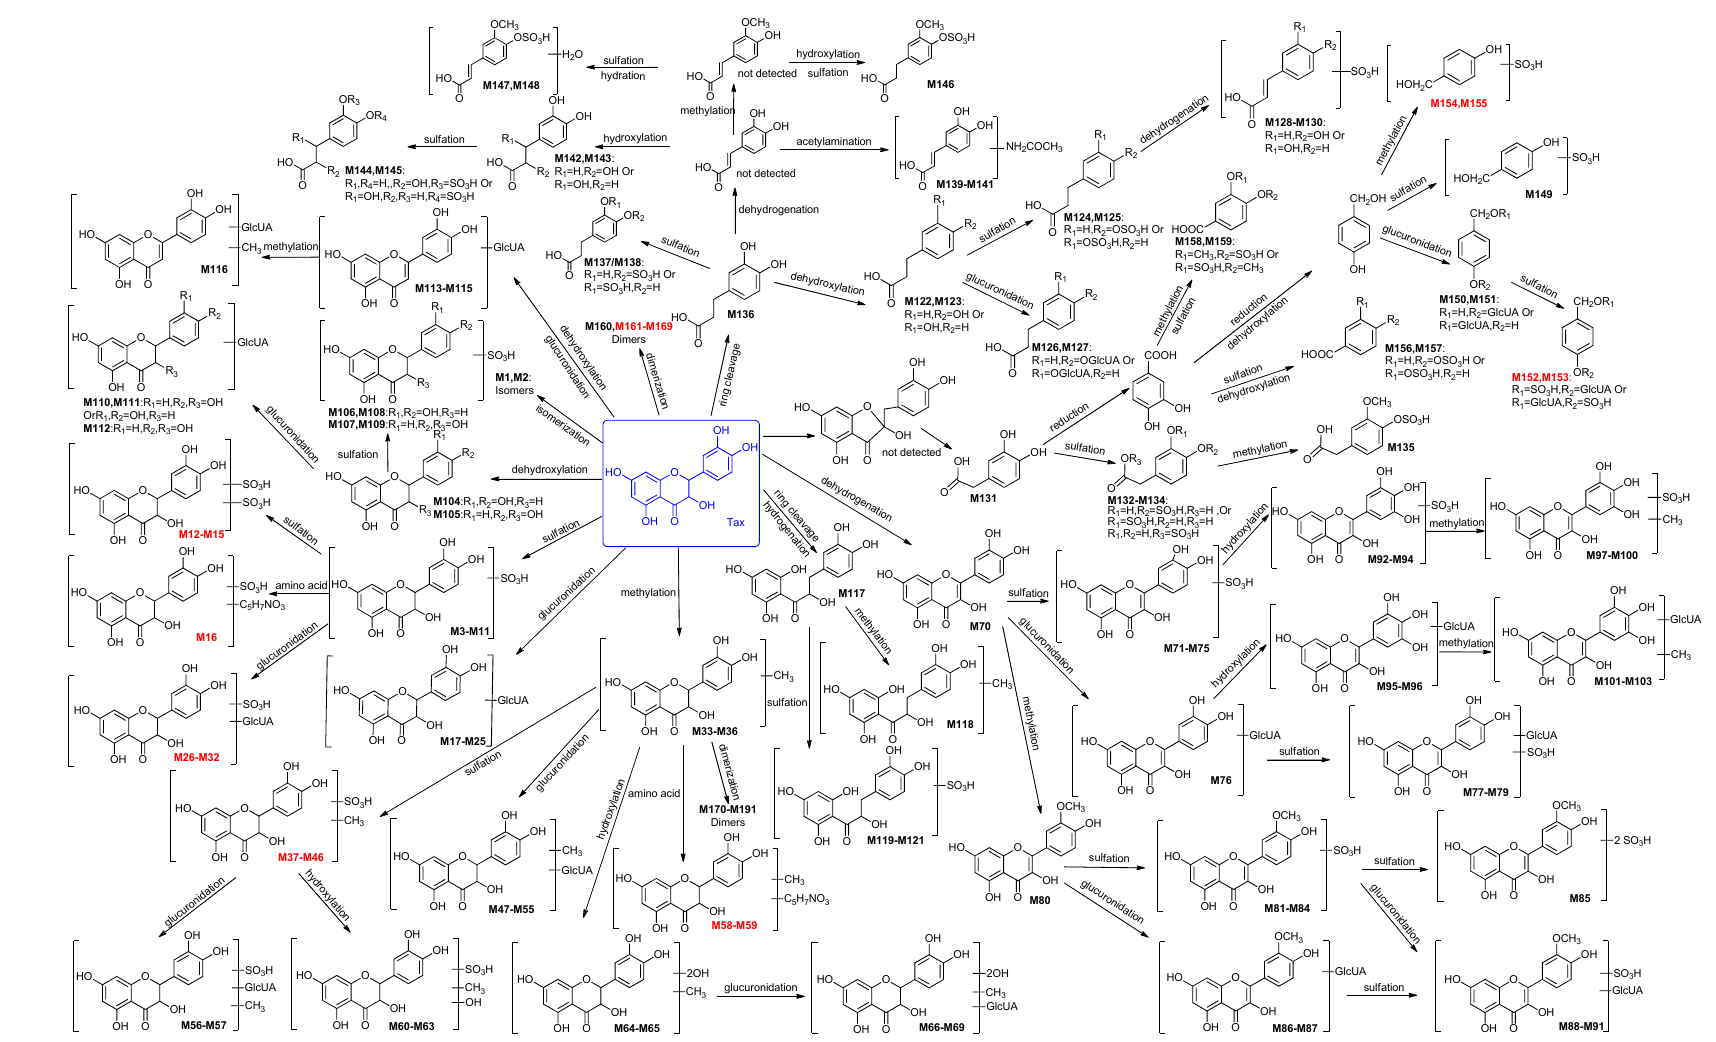
Figure 1. The proposed metabolic pathways of taxifolin in rats, with M1 – M191 metabolites. The blue is taxifolin, the red shows new compound.